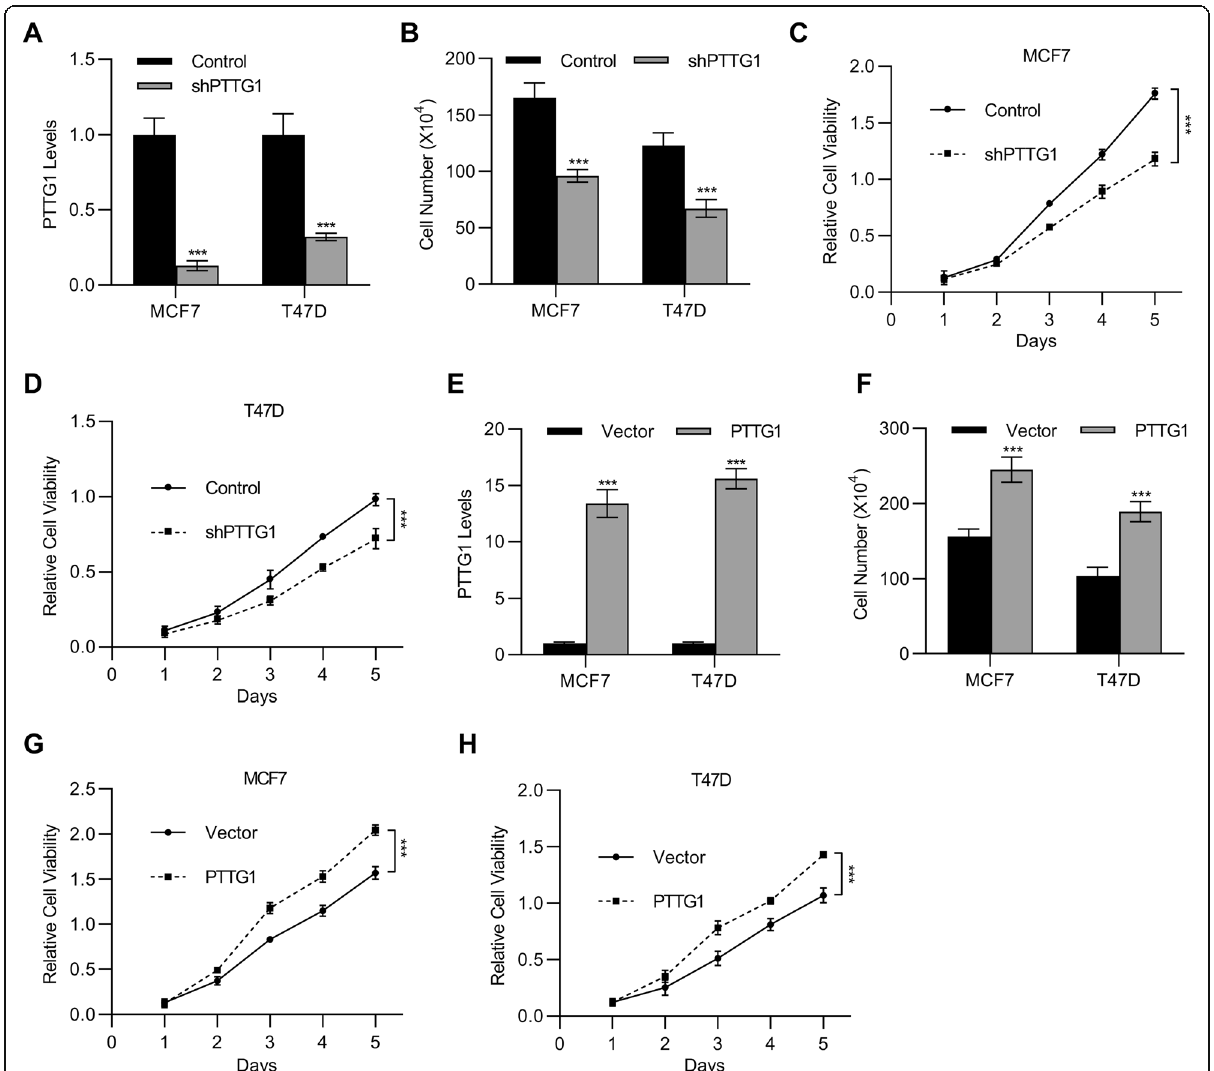
Fig. 2 PTTG1 promoted the proliferation of breast cancer cells. a qPCR was employed to detect the mRNA levels of PTTG1 in the cells including MCF7 and T47D that were transfected with shPTTG1 or negative control shRNA. n = 3. After that, ( b-d ) Cell count ( b ) or MTT ( c-d) assay was used to determine the cell viabilities. n = 7. Additionally, ( e ) cells including MCF7 and T47D were used to establish PTTG1 overexpression cell lines. qPCR was employed to detect the mRNA levels of PTTG1 in the cells. n = 3. f-h Cell count ( f ) or MTT ( g-h ) assay was used to determine the cell viabilities. n = 7. Data are represented as mean ± S.D. *** P <